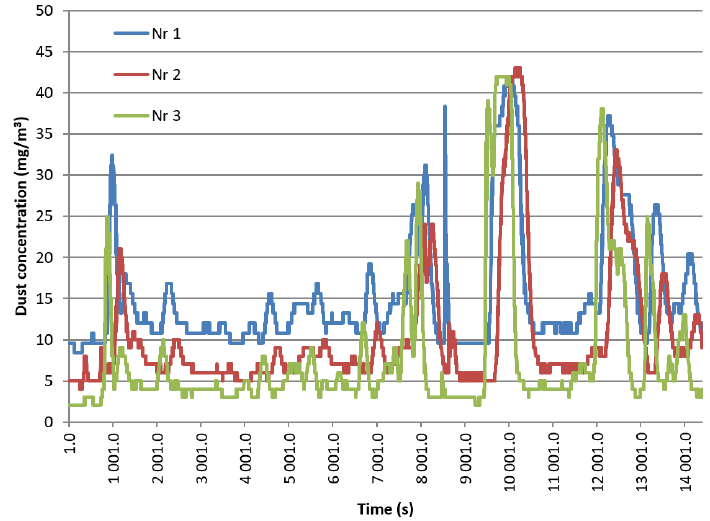
8 of 17 Figure 11. Characteristics of the distribution of PM2.5 dust concentration depending on the distance from a dust source, measured with the IPSQ analyzer in coal faces, together with the functions that